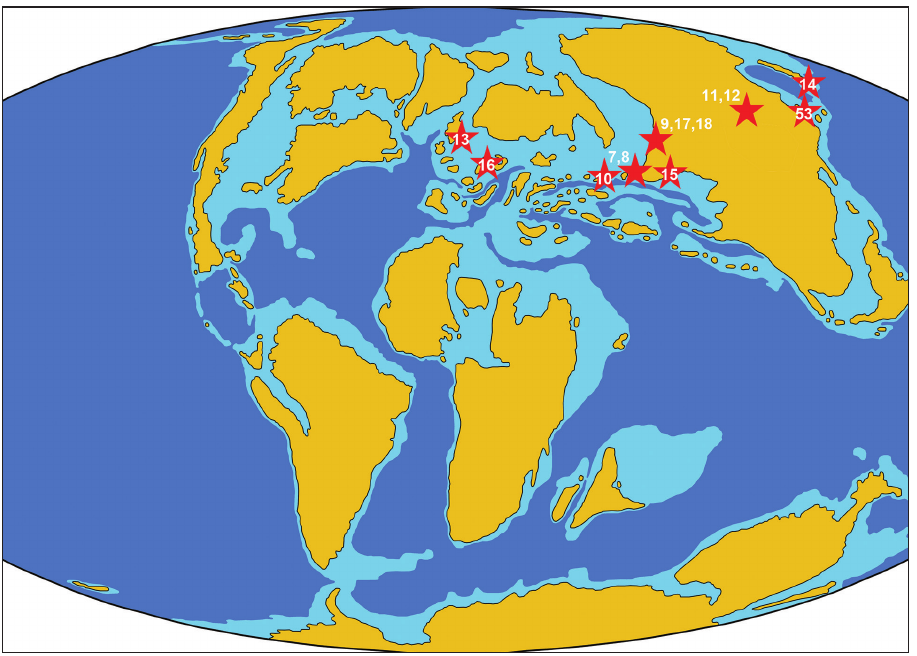
Figure 4. Paleogeographic map of the Late Cretaceous (90 Ma) showing Turonian-to-Santonian-age localities of azhdarchids. The numbers of localities correspond to the list in the text. The map is modified from